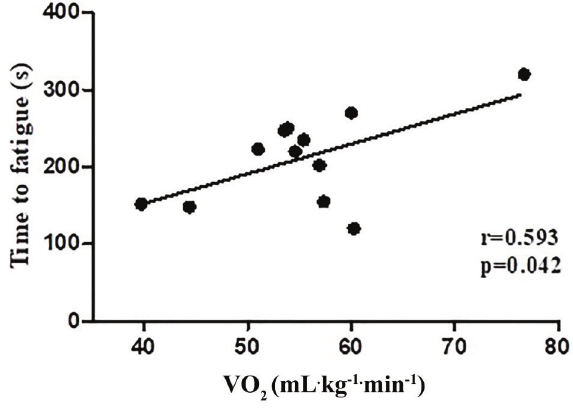
Figure 6. Pearson correlation between fatigue time and oxygen uptake (VO 2 ) during critical load.